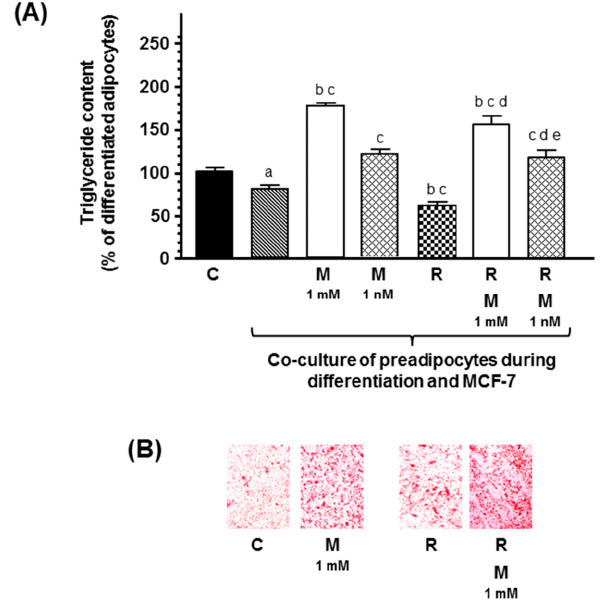
Figure 5. (A) Effects of melatonin on radiation-induced changes on intracytoplasmic triglyceride content in breast fibroblasts during the course of differentiation, in the presence of human breast cancer cells (MCF-7). Data are expressed as the percentage of the differentiated adipocytes (C) (mean ± SEM). a, p < 0.001 vs. C; b, p < 0.05 vs. C; c, p < 0.001 vs. differentiated adipocytes co-cultured with MCF-7 cells; d, p < 0.05 vs. differentiated adipocytes co-cultured with MCF-7 cells and radiated; e, p < 0.001 vs. differentiated adipocytes co-cultured with MCF-7 cells, radiation, and melatonin (1 mM). (B) Representative images of the Oil Red O staining. C: control, M: melatonin, R: radiation.